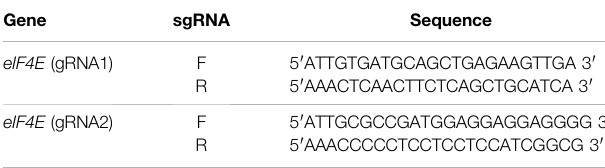
TABLE 1 | eIF4E gRNA sequences. Gene sgRNA